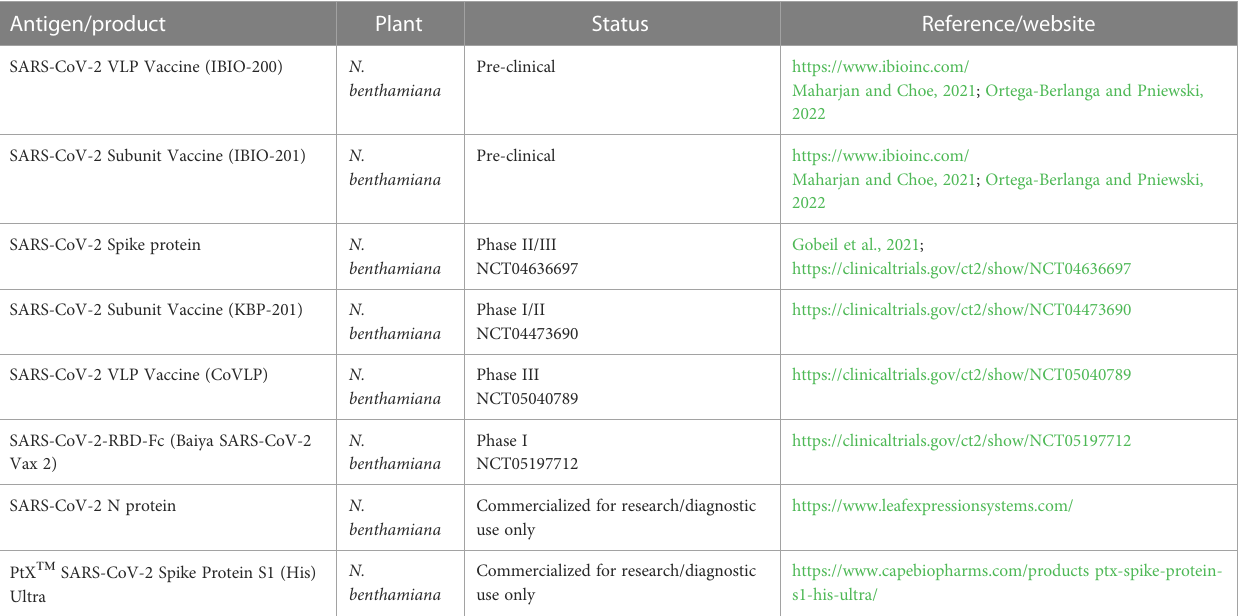
TABLE 1 Examples of plant-based vaccines against